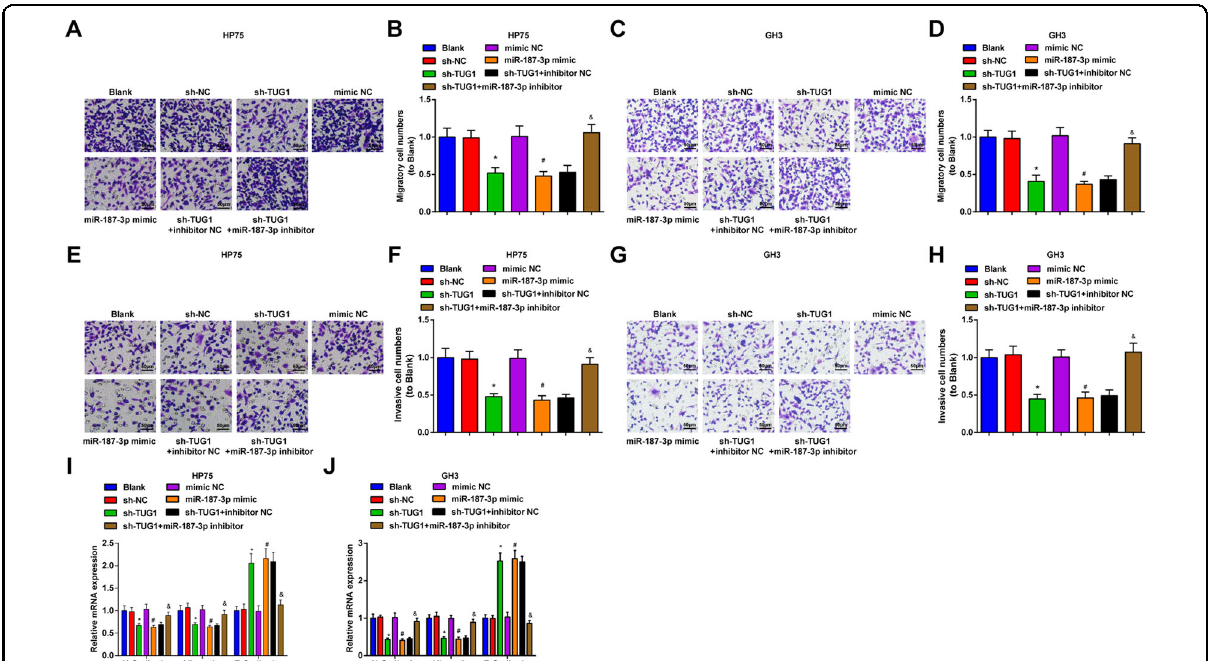
Fig. 5 Inhibited TUG1 or elevated miR-187-3p decelerates migration and invasion of PA cells. A migration ability of HP75 cells was assessed by Transwell assay; B statistical results of migration ability of HP75 cells; C migration ability of GH3 cells was assessed by Transwell assay; D statistical results of migration ability of GH3 cells; E invasion ability of HP75 cells was assessed by Transwell assay; F statistical results of invasion ability of HP75 cells; G invasion ability of GH3 cells was assessed by Transwell assay; H statistical results of invasion ability of GH3 cells; I mRNA expression of EMT- related factors N-Cadherin, E-Cadherin, and Vimentin in HP75 cells was detected using RT-qPCR; J, mRNA expression of EMT-related factors N- Cadherin, E-Cadherin, and Vimentin in GH3 cells was detected using RT-qPCR; repetitions = 3. Data are presented as mean ± SD. * P < 0.05 vs the sh- NC group, # P < 0.05 vs the mimic NC group, & P < 0.05 vs the sh-TUG1 + inhibitor NC group.